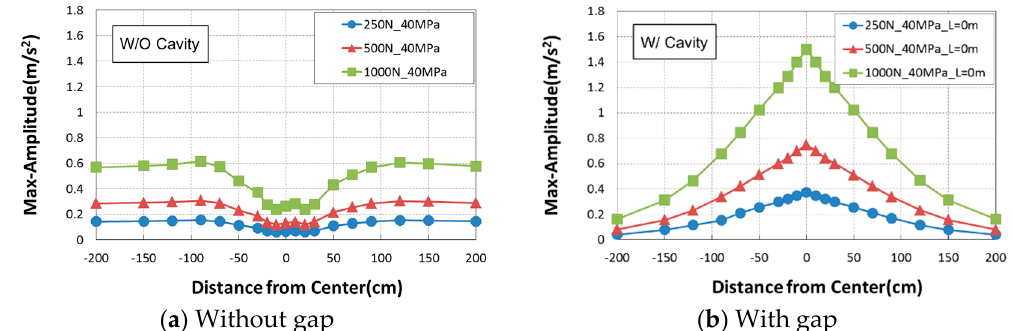
Figure 6. Comparison of maximum acceleration amplitudes on concrete surface in cases of with and without gap at different positions from impact loading point. ( a ) Without gap. ( b ) With gap.